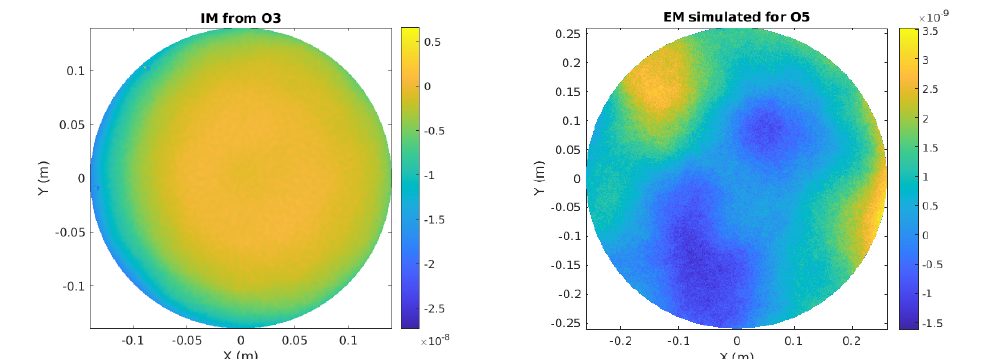
Figure 3. ( Left ) IM surface-map obtained from measurements of the IM surface at Virgo in O3, obtaining a roughness of the order of nanometers. We decided to use the map measured up to 0.29 m in diameter. However, the extrapolation to the mirror edge is negligible, so we do not show it in this plot. A detailed description on the measurements leading to these surface maps can be found in Ref. [14]. ( Right ) EM- simulated surface-map. Notice the larger aperture of EM (0.52 m). For the large O5 mirrors, no real data are available as the substrates are currently in the polishing phase. Thus, for the simulation, we rely on simulated surface maps having the same spatial characteristics as the current mirrors as the polishing specifications are identical for the O3 and O5 mirrors (albeit for O5, the specifications are defined on a larger diameter).